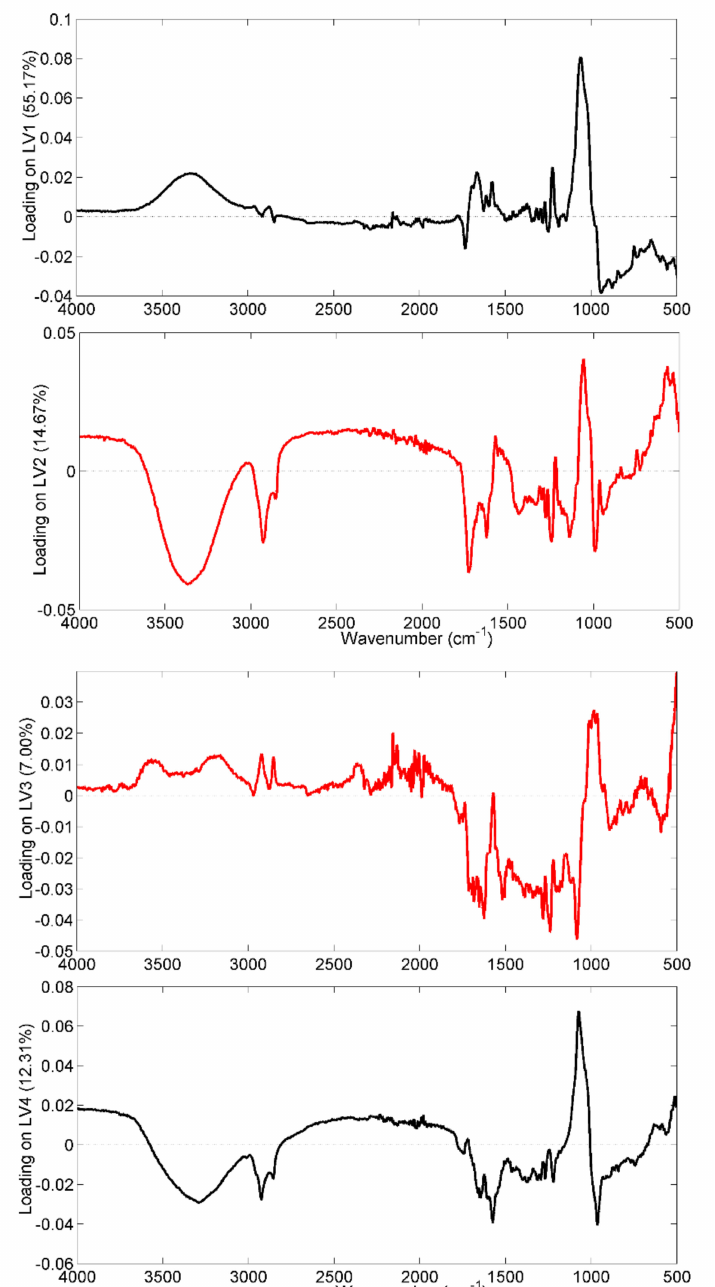
Figure 4. Loadings of the spectral variables on the four considered Model I LVs. Highlighted in red are the loadings on LV2 and LV3, the directions along which a trend related to spice aging and the annual microclimatic effects, respectively, could be